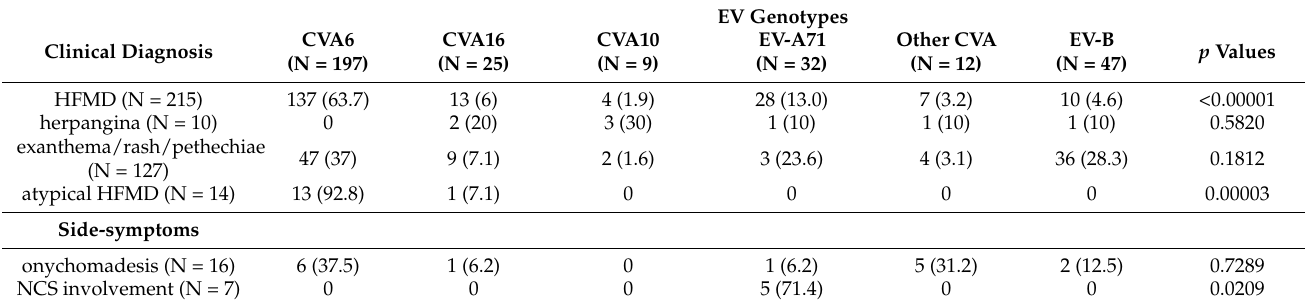
Table 2. Comparison between different EV type-infections and clinical symptoms presented by the patients included in the